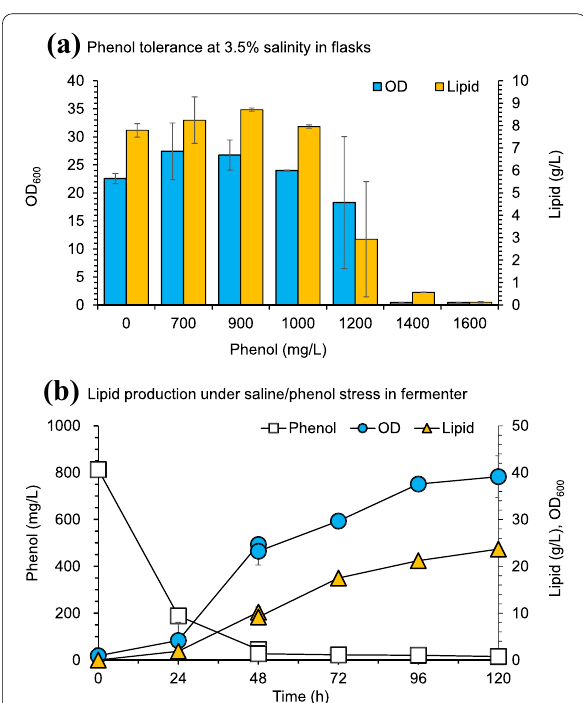
Fig. 6 Phenol tolerance and lipid production of T. cutaneum MP11 in saline water. a Phenol tolerance at 3.5% salinity in flasks. 35 g/L NaCl and defined phenol were added into the synthetic medium. T. cutaneum MP11 was cultured at 30 ℃ for 120 h. b Lipid production in the medium containing 35 g/L of NaCl and 1000 mg/L of phenol. The initial concentration of glucose is 60 g/L, and added to 150 g/L at 48 h. All experiments were performed in